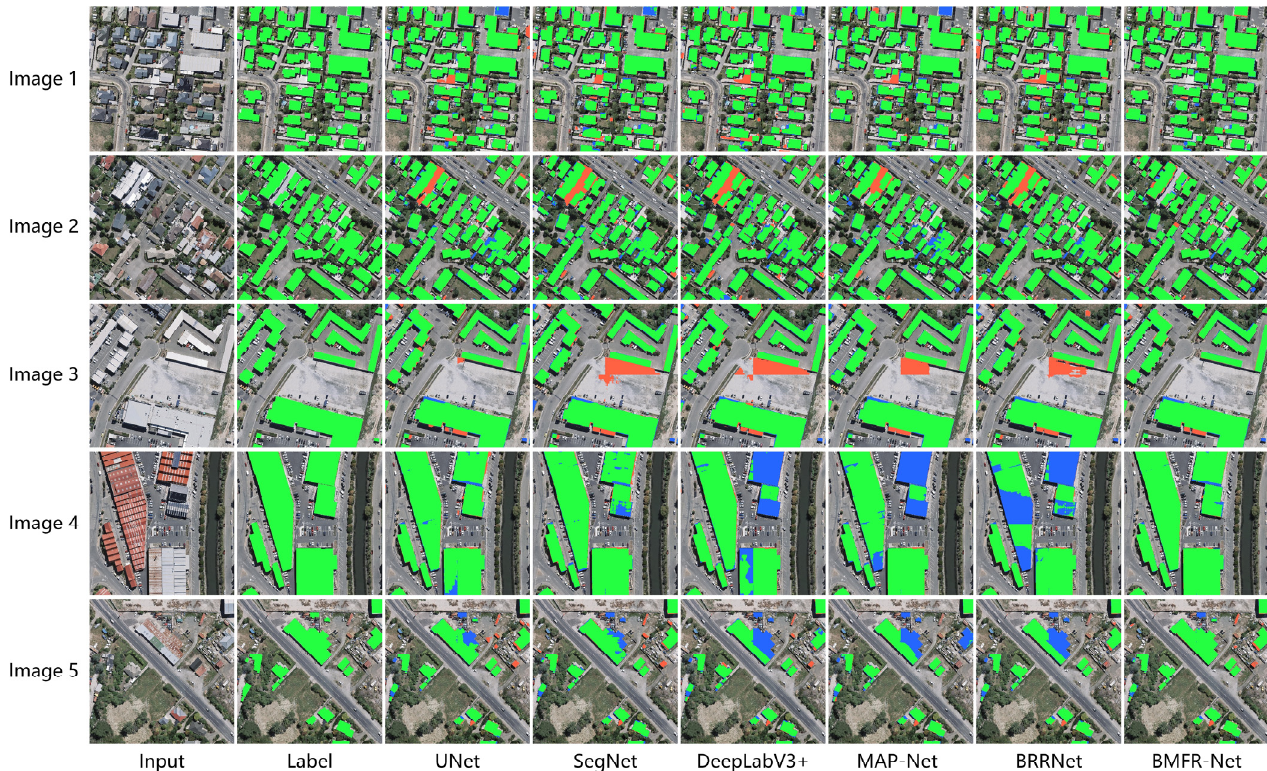
Figure 10. Typical building extraction results by different methods on WHU Buildings Dataset. In the graph, green represents TP, red represents FP, and blue represents FN.